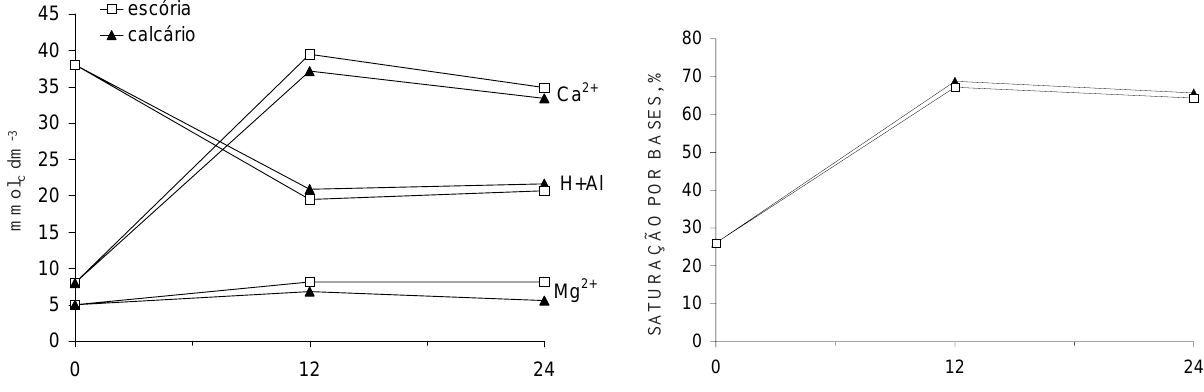
Figura 1. Efeito do tempo de aplicação do calcário e da escória de siderurgia em alguns atributos químicos de um Latossolo Vermelho-Amarelo cultivado com cana-de-açúcar. (Dados médios de quatro doses e quatro